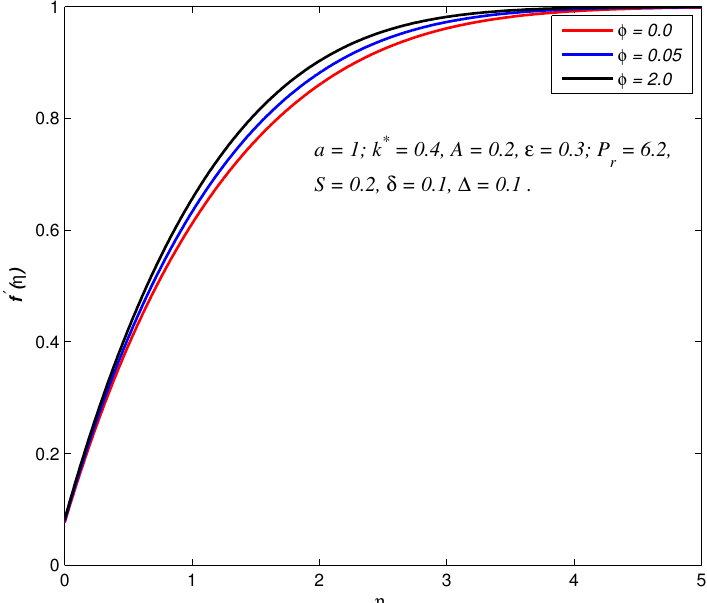
Figure 5. Velocity f (cid:48) ( η ) profiles for different values of volume fraction coefficient φ .